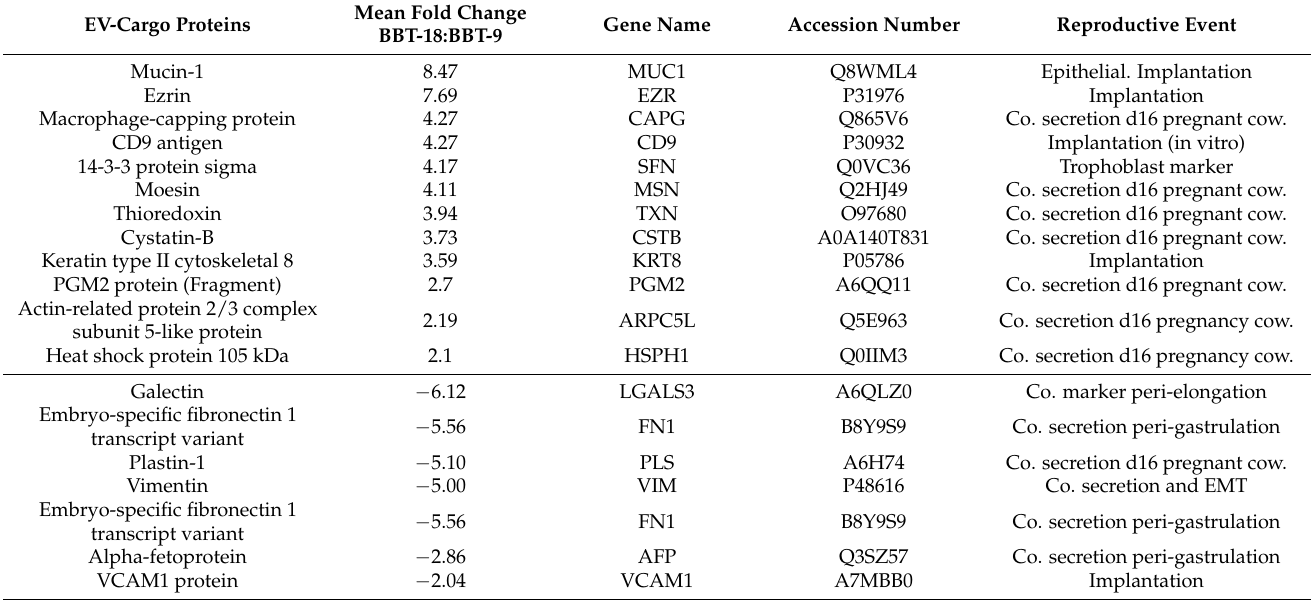
Table 1. Top early pregnancy-related proteins differentially abundant between BBT-18- and BBT-9-EV-cargo detected by iTRAQ-LC-MS/MS analysis.